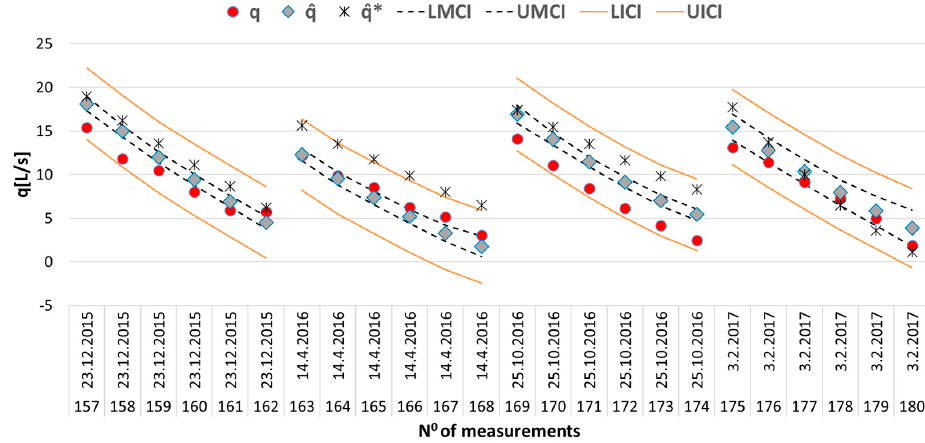
Figure 8. Measured and modeled values of total losses during verification period 2015–2017. In Figure 8, 𝑞 represents the measured values, 𝑞(cid:3548) represents the model values ac- cording to the model (10) in this paper, and 𝑞(cid:3548) ∗ represents the model values of water losses according to the model given in paper [4]. Test sessions refer to the last four ses- sions, sessions 76–79, i.e., measured values 157–180. 𝐿𝑀𝐶𝐼 , 𝑈𝑀𝐶𝐼 , 𝐿𝐼𝐶𝐼 , and 𝑈𝐼𝐶𝐼 repre- sent the lower (L) and upper (U) limits of the confidence intervals for the expected mean (M) and individual values (I) of the model (10). The accuracy of the model for the test period is RMSE Test = 2.0161 L/s. Model (10) is additive, and Figure 9a shows the aggregate effects of regressors grouped by their physical context. The additive component 𝑎𝐻𝑠𝑡 represents the sum of linear and quadratic hydrostatic effects ( 𝐻 (cid:3046)(cid:3047) and 𝐻 (cid:3046)(cid:3047)(cid:2870) ), 𝑎𝑇𝑤𝑐𝑐 represents the sum of linear ( 𝑇 (cid:3050)(cid:3030)(cid:3030) ) and quadratic ( 𝑇 (cid:3050)(cid:3030)(cid:3030)(cid:2870) ) thermal and size of crack openings effects, while component 𝑎ℎ𝑃 is the sum of hydrostatic effects of groundwater measured by piezometers P 3 and P 4 . Component 𝑇 (cid:3050)(cid:3030)(cid:3030) ⋅ 𝐻 (cid:3046)(cid:3047) represents the interaction effects of appropriate PCs, and 𝑡 —en- compasses the effect of rheology on aging and deterioration of concrete ( 𝑒 (cid:2879)(cid:3047) ).